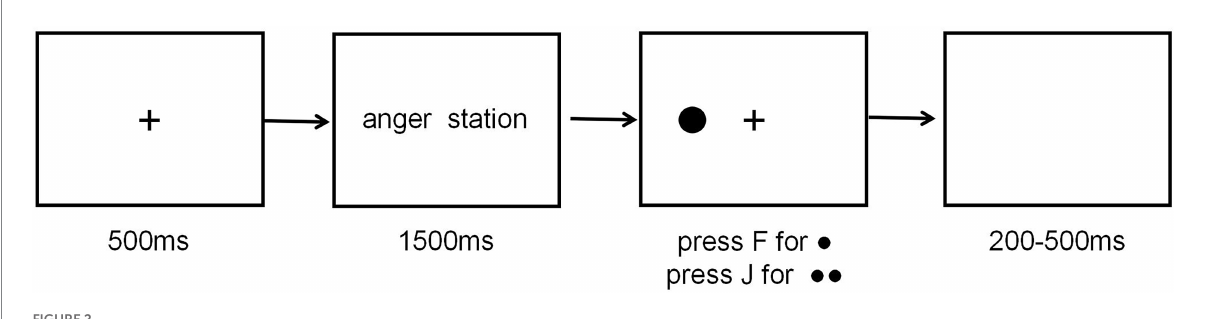
FIGURE 2 An example of the paradigm used to measure and modify attentional